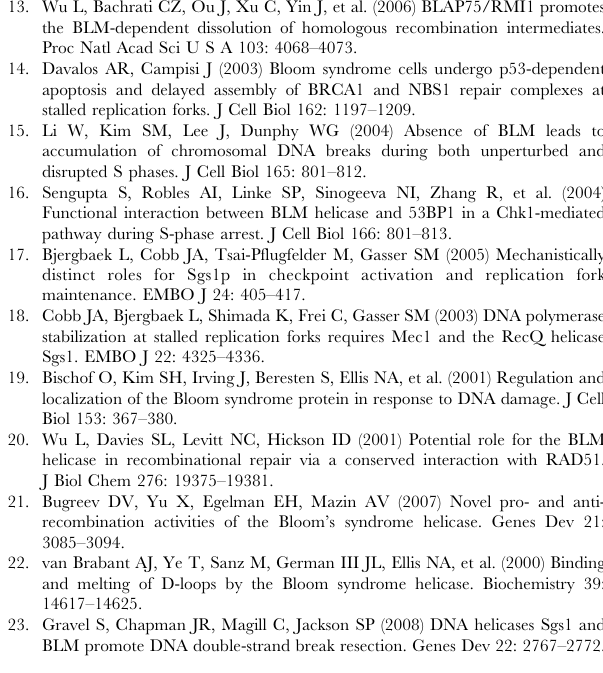
Figure S4 BS cell phenotypes differ from SM-BLM cell phenotypes. (A) HU induces increased levels of SCEs in BS cells. BS cells (GM08505) were incubated with 10 m M BrdU for 30 h, treated or not with 0.5 mM HU for 24 h, and then returned to BrdU-containing medium for an additional 20 h. Metaphases were collected in colcemid. Two photomicrographs are shown of metaphases in which exchanges between sister chromatids were visualized. Average numbers of SCEs/46 chromosomes for untreated and HU-treated BS cells is shown beneath the photomicrographs (number of metaphases counted). (B) HU- treated BS cells (GM08505) exhibit excess colocalization of RAD51 and c -H2AX, demonstrating that RAD51 is effectively recruited to damaged replication forks in the absence of BLM. Bars indicate 10 m m. Found at: doi:10.1371/journal.pbio.1000252.s004 (5.80 MB PDF) Figure S5 Graphical representation of mean numbers of colocalized RAD51 and BLM foci in untreated (NT) and HU-treated (HU) BLM + and SM-BLM cells. Figure S6 Impaired localization of RAD51 to damaged forks in SUMO-mutant BLM cells after a short treat- ment with HU. BLM + and SM-BLM cells were untreated (NT) or synchronized with 0.5 mM mimosine for 24 h, which stalls cells in late G1 phase, released into normal medium for 5 h to allow the cells to enter S phase, then treated (MIM + HU) or not (MIM rel) with 10 mM HU for 1 h and evaluated for RAD51 localization with BLM and c -H2AX. BrdU flow cytometry, as performed in Figure S1, confirmed that . 80% of the cells had entered S phase by 5 h after release. Data presented are the average of two experiments in each of two BLM + and two SM-BLM clones. Bars represent the mean numbers of foci or colocalized foci per nucleus, and the error bars represent the standard deviations of the combined data. After 1 h of treatment with 10 mM HU, RAD51 foci increased in BLM + cells but were effectively unchanged in SM-BLM cells. These effects on RAD51 localization are observed